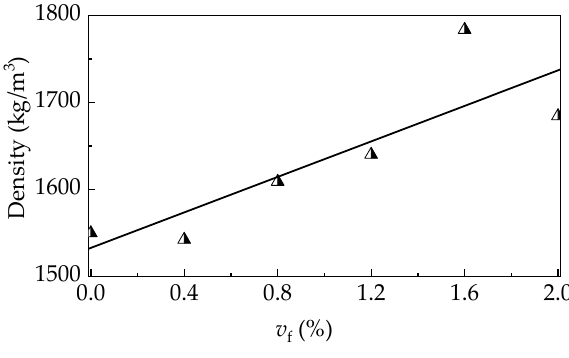
Figure 9. Variation of the density with v f.